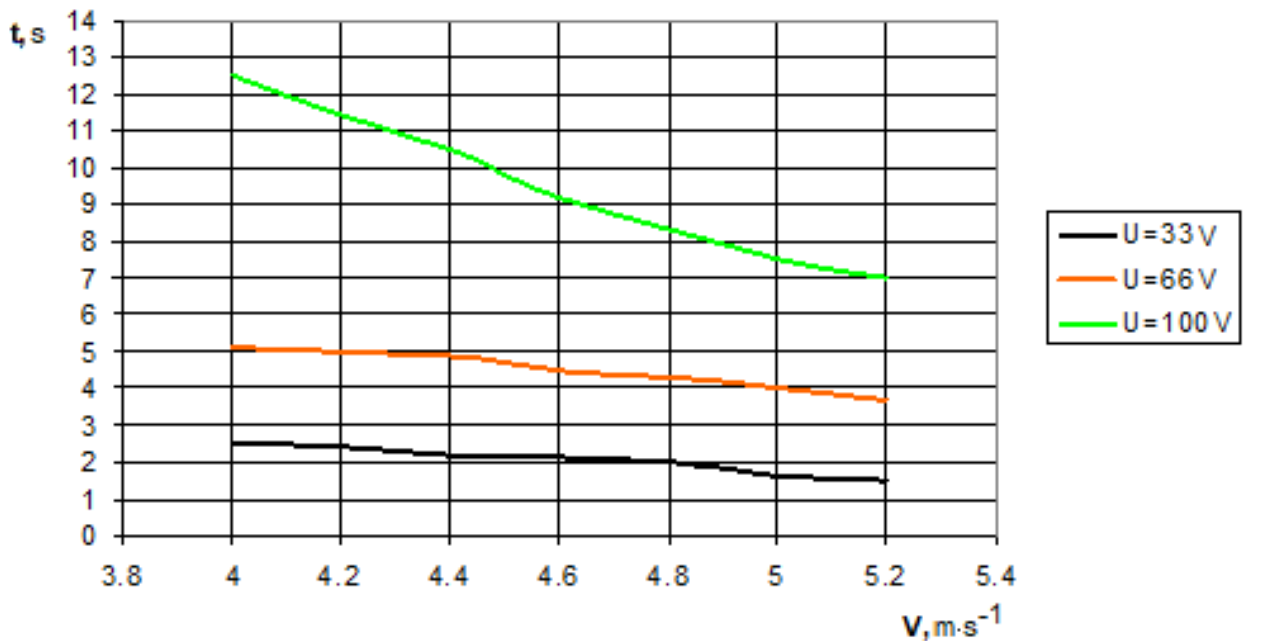
Figure 5. Dependence of the change in time of reaching the limit of different thresholds of operation of the keys responsible for the start of discharge of the capacitive storage device, depending on the values of the mathematical expectation of wind speed [own elaboration], graph that visually show the dependence of the corresponding functions on the arguments.